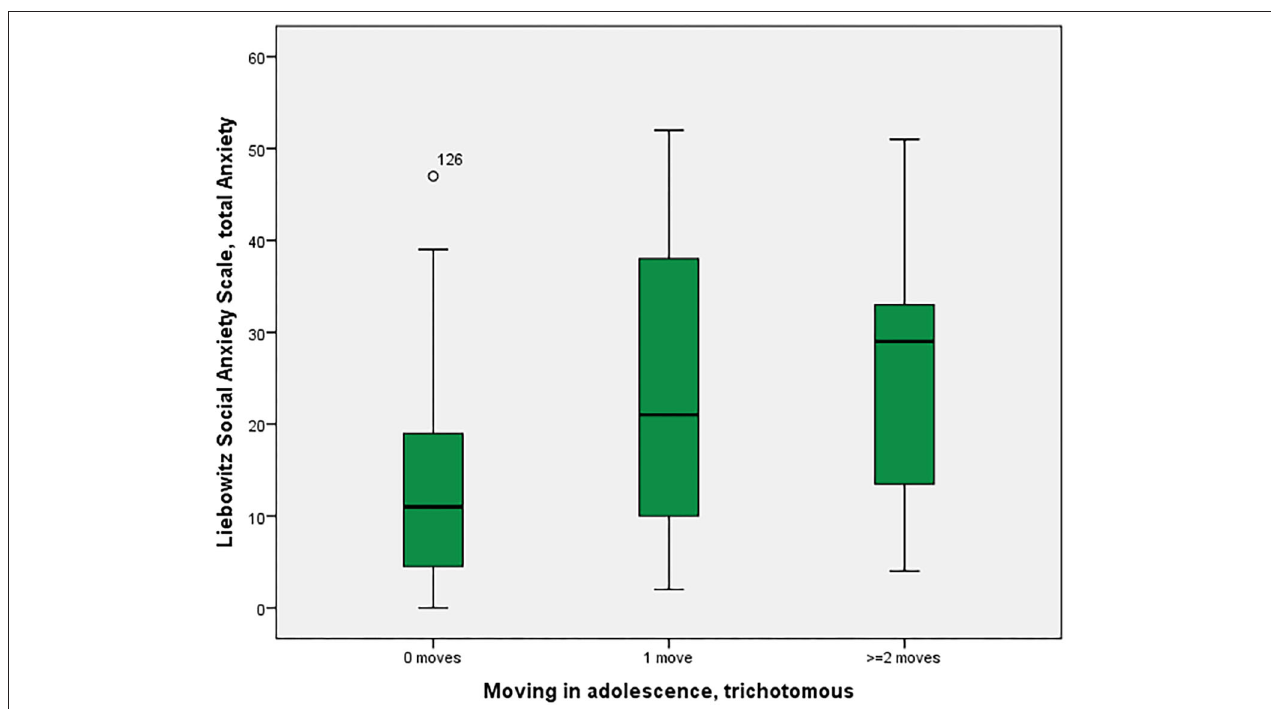
FIGURE 1 | Residential mobility in adolescence and social anxiety in adulthood. Boxplot for the group comparison in social anxiety (Liebowitz Social Anxiety Scale, Anxiety) between subjects who did not move during adolescence (M = 13.4, SEM = 1.5, n = 52) with subjects who moved one time (M = 23.7, SEM = 4.7, n = 12) and twice or more than twice (M = 25.3, SEM = 6.2, n = 7). The ANOVA for simultaneous 3-group comparison is significant ( p uncorrected = 0.007, with Bonferroni-Holm correction p = 0.021). Uncorrected post-hoc Tukey tests showed a significant result for zero moves vs. one move ( p = 0.034), but not for the other comparisons (zero with two or more: p = 0.055; one with two or more: p = 0.960).